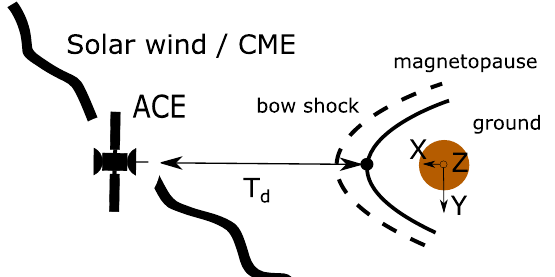
Fig. 3. Schematic of the three-part division of the solar wind propagation delay T D from L1 (ACE) to Earth. Namely, (1) delay between L1 and bow shock, (2) between bow shock and magne- topause, and (3) between magnetopause and ground, after (Mailyan et